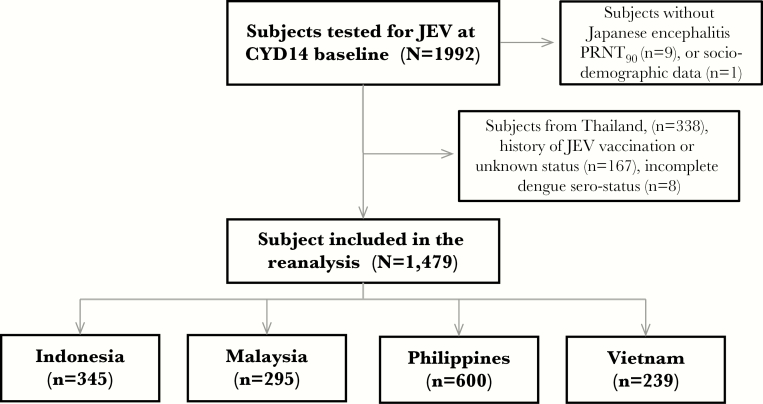
Study flow chart.